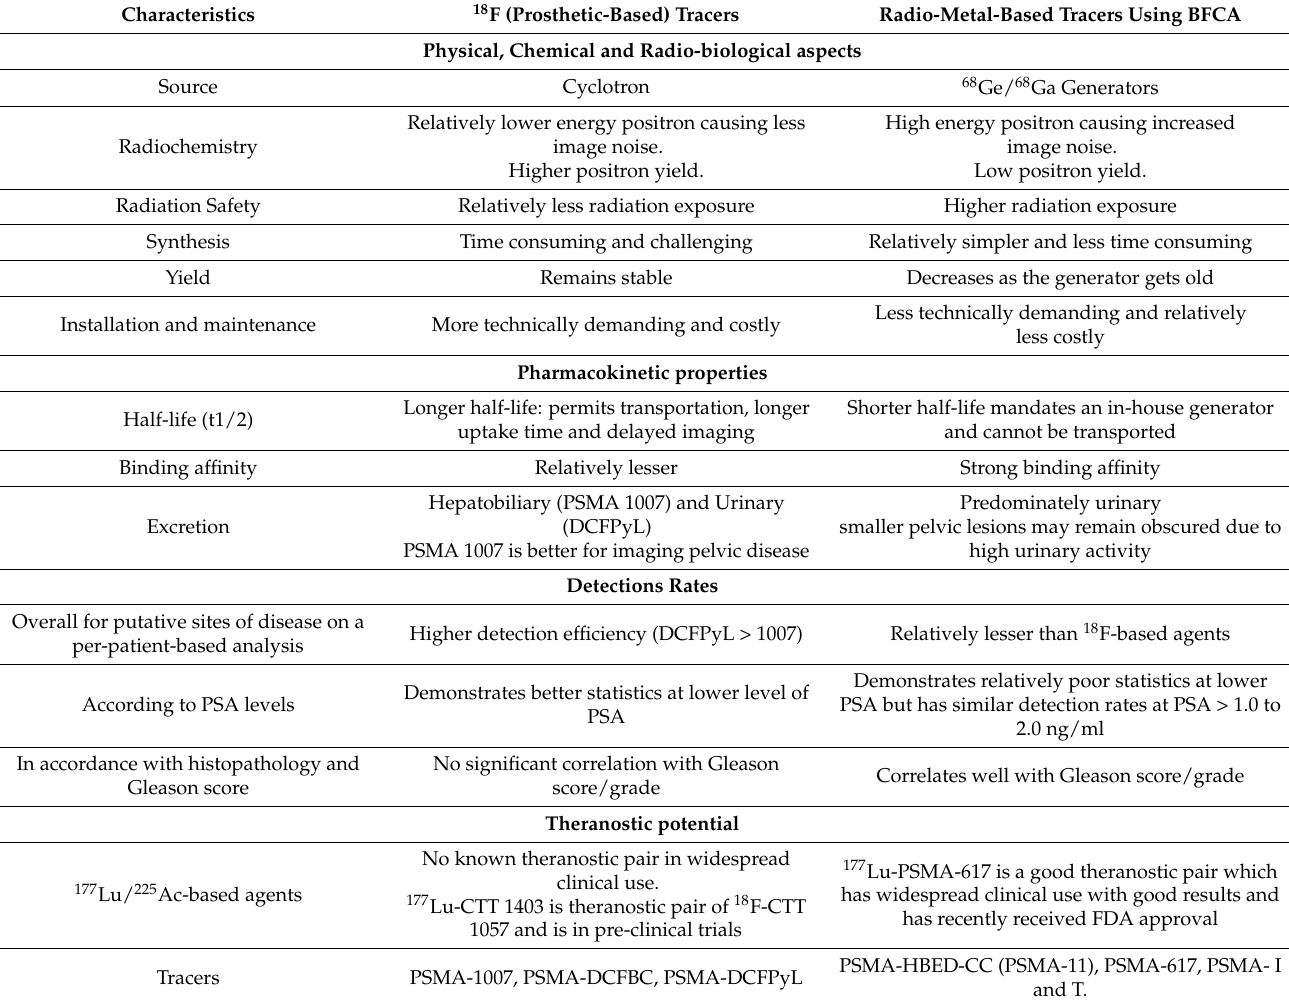
Table 1. Head-to-head comparison of 18F (prosthetic-based) and BFCA chelated radio-metal-based tracers targeting PSMA for imaging prostate